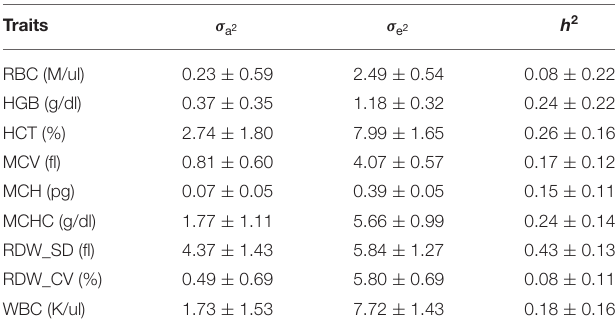
TABLE 3 | Variance components and estimates of heritability for hematologic traits.